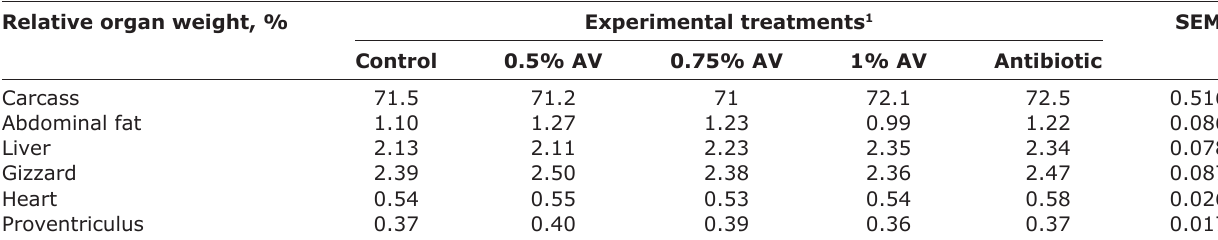
Table-4: Effect of experimental treatments on carcass yield and internal relative organ weight of broilers at 42 days of age. Relative organ weight, %